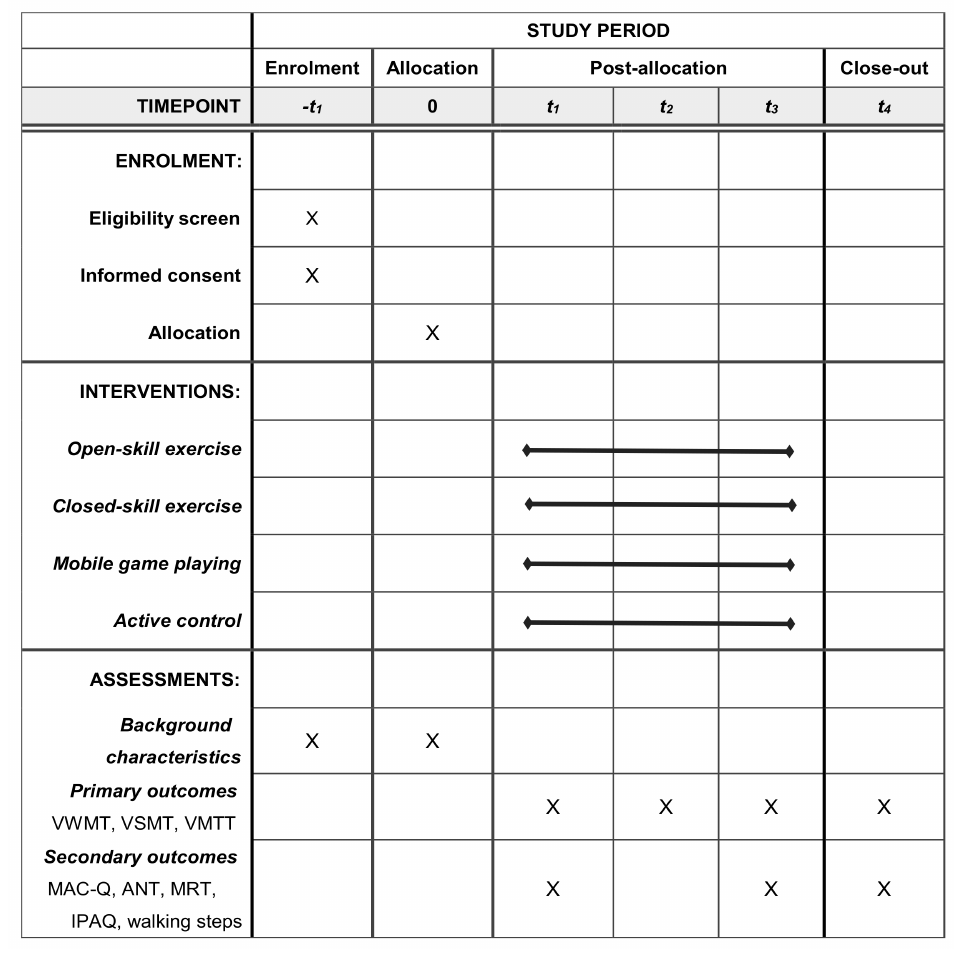
Figure 2. Schedule of enrolment, interventions, and assessments of the trial. t 1 : baseline (week 1), t 2 : intermediate of intervention (week 13), t 3 : immediately post-intervention (week 25), t 4 : twelve weeks after intervention (week 37), VWMT: visuospatial working memory task, VSMT: visuospatial short-term memory task, VMTT: visuospatial mental rotation task, MAC-Q: Memory Complaint Questionnaire, ANT: attention network test, MRT: matrix reasoning test, IPAQ: International